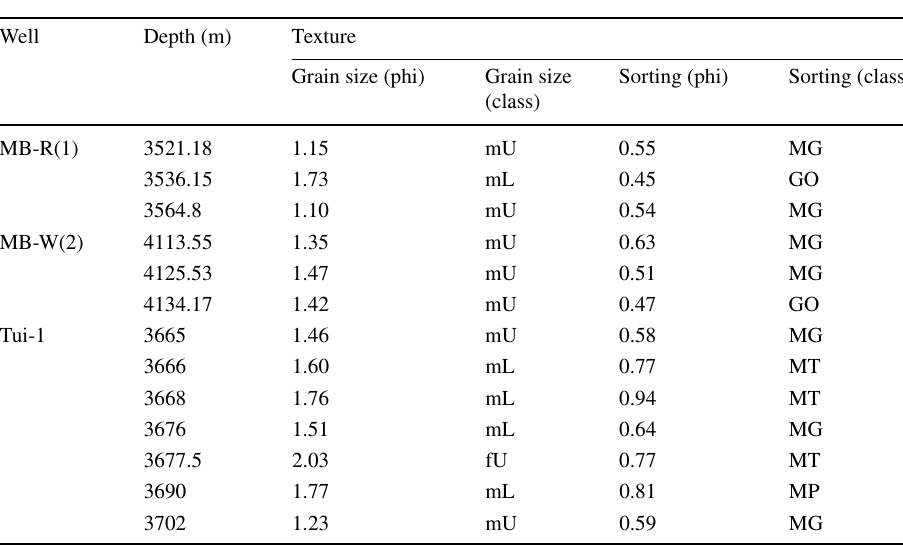
of selected samples of Farewell